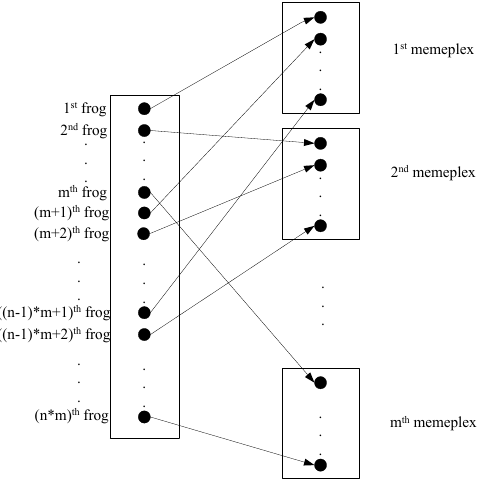
Figure 3. The memeplex partitioning